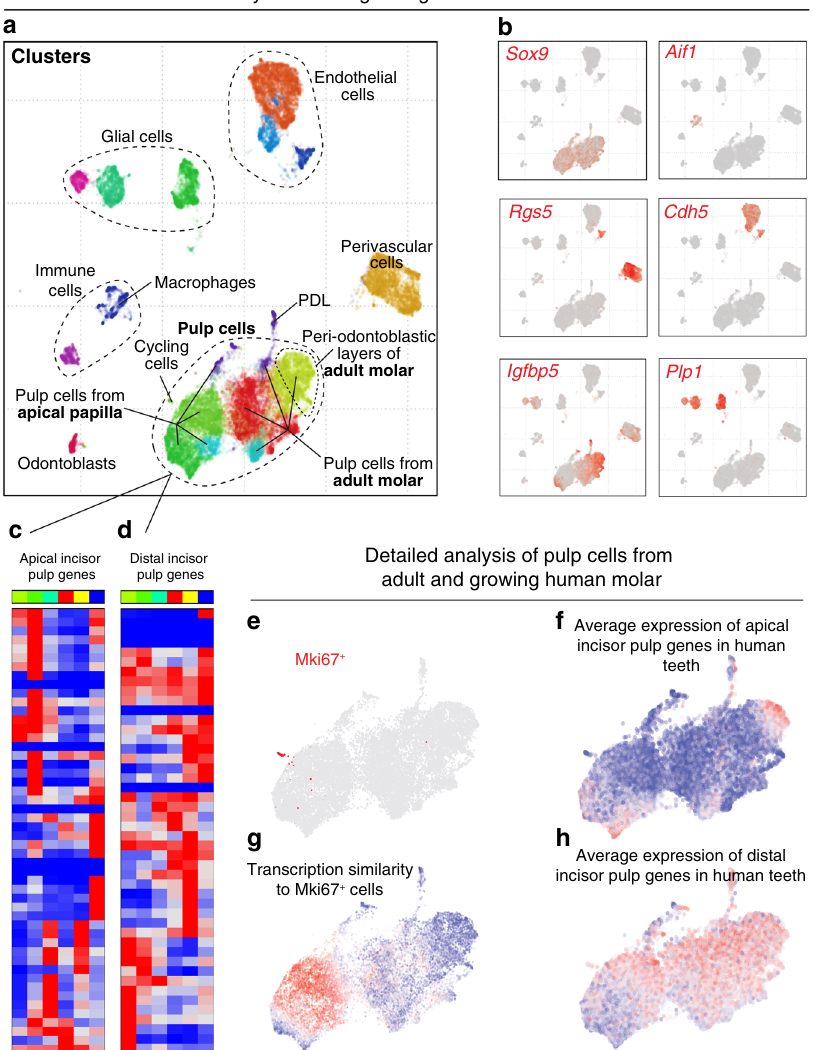
Fig. 9 Analysis of adult and growing human molars. a Dental cell types in human teeth, see Fig. 4. b Expression of selected marker genes. c , d Expression of genes coordinately active in apical (51 genes, c ) or distal (48 genes, d ) incisor pulp across clusters of human mesenchyme reveals divergence of pulp expression programs. Apical incisor genes were de fi ned as at least three-fold and signi fi cantly ( p < 10 − 10 , two-sided t -test) overexpressed in apical compared to distal incisor pulp in both 10× Chromium and Smart-seq2 datasets. The same for distal incisor genes. e Expression of MKI67 in cells of human pulp shows a group dividing cells. f Transcriptional similarity of the group of dividing cells to individual nondividing mesenchyme cells. g , h Average expression of apical incisor genes ( g ) and distal incisor genes ( h ) in cells of human mesenchyme outline tendency to expression in complementary cell